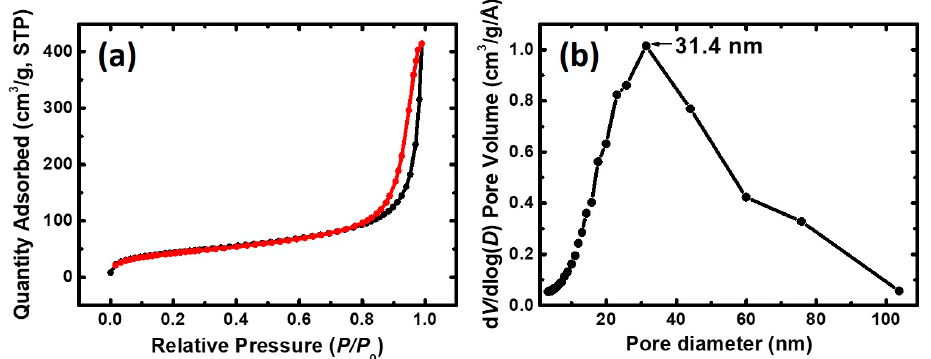
Figure 3. ( a ) N 2 -sorption isotherm for spherical PUA aerogel beads; ( b ) Barrett–Joyner–Halenda (BJH) pore size distribution.